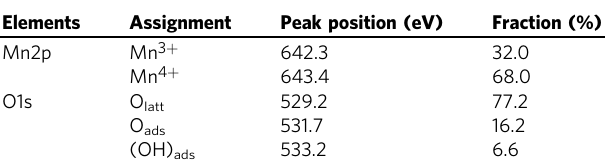
Table 1 Mn2p, O1s binding energies, and the corresponding